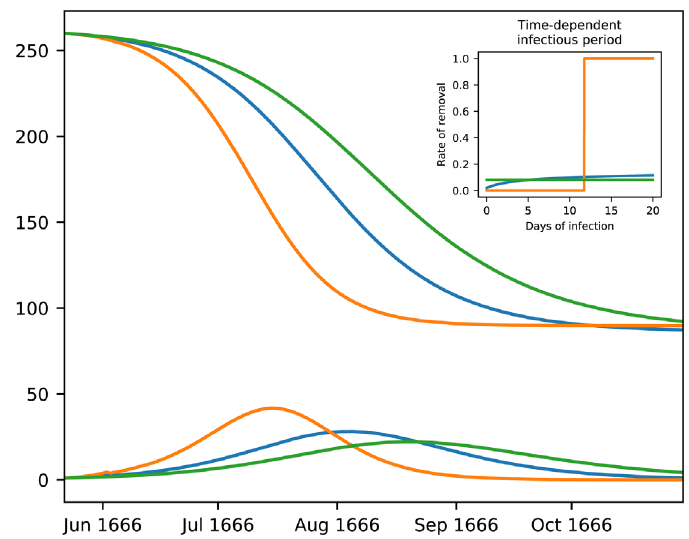
Figure 6. The effect of age-structure in modelling epidemics. The outbreak trajectory shown in Figure 5(b) (blue lines) is compared with alternative forms of mortality. Green lines indicate time-independence where the gamma distributed infectious period has σ = µ . Orange lines indicate that the infectious period has a precise length of µ = 11 . 71 days ( σ = 0).